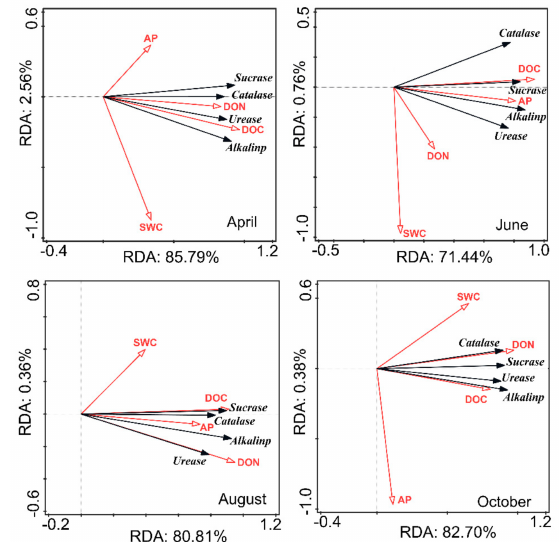
Figure 5. The results of redundancy analysis (RDA) to identify the relationships between the soil enzyme activities (black arrows) and soil properties (red arrows) in di ff erent months (marked in each part of the figure) across all land-use types and soil depths. For each subfigure, n (36) = four land-use types × three soil depth × three replications. The percentages on the x-axis and y-axis reflect the response rate of the soil properties to the changes in soil enzyme activities in di ff erent dimensions. DOC, DON, AP, and SWC represent dissolved organic carbon, dissolved organic nitrogen, available phosphorus, and soil water content,